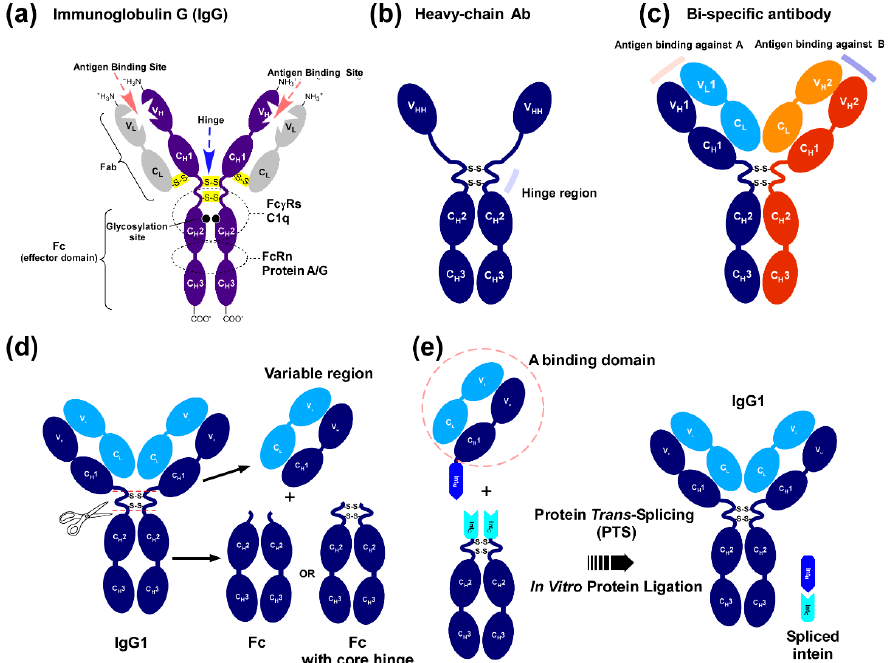
Figure 1. Domain structures of immunoglobulin G (IgG) and IgG variants. ( a ) Domains in IgG with their functional roles. ( b ) Domain structure of a heavy-chain antibody. ( c ) Domain structure of an engineered bispecific antibody showing each unique chain highlighted in different colors. Dissection of immunoglobulin G (IgG). ( d ) IgG can be split into the Fab region, which contains an antigen-binding site, and the effector domain Fc at two positions in the hinge region. ( e ) Reconstitution of IgG-like molecules by protein ligation using protein trans -splicing (PTS) with a split intein. The figure was adapted from [5].